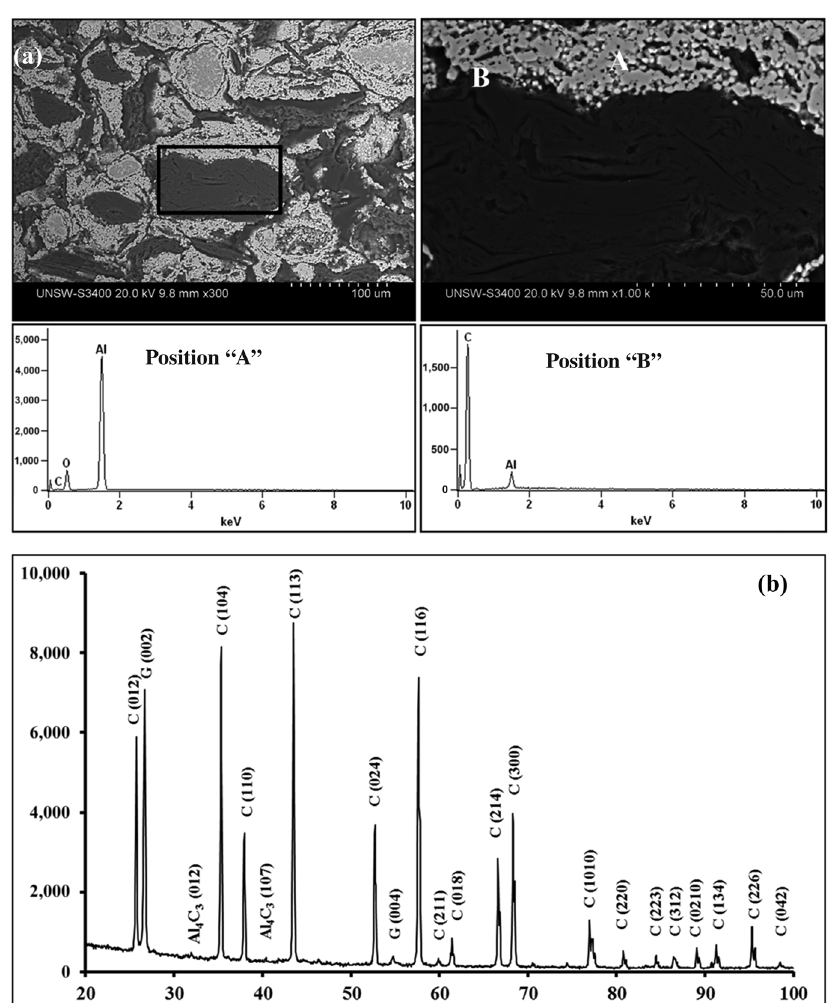
Figure 3: (a) SEM image and EDS analysis of AS1 sample and (b) XRD pattern of AS1 substrate showing various diffraction peaks. These peaks have been labeled as corundum, C; graphite, G; aluminum carbide, Al 4 C 3